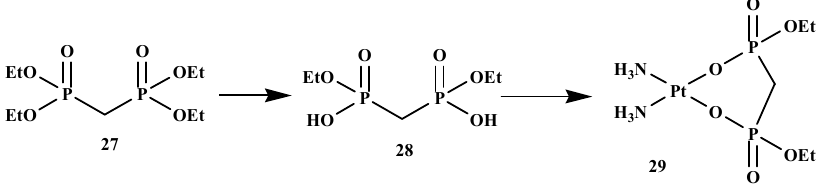
Figure 5. BP-conjugate 29 Figure 5. BP ‐ conjugate 29 .